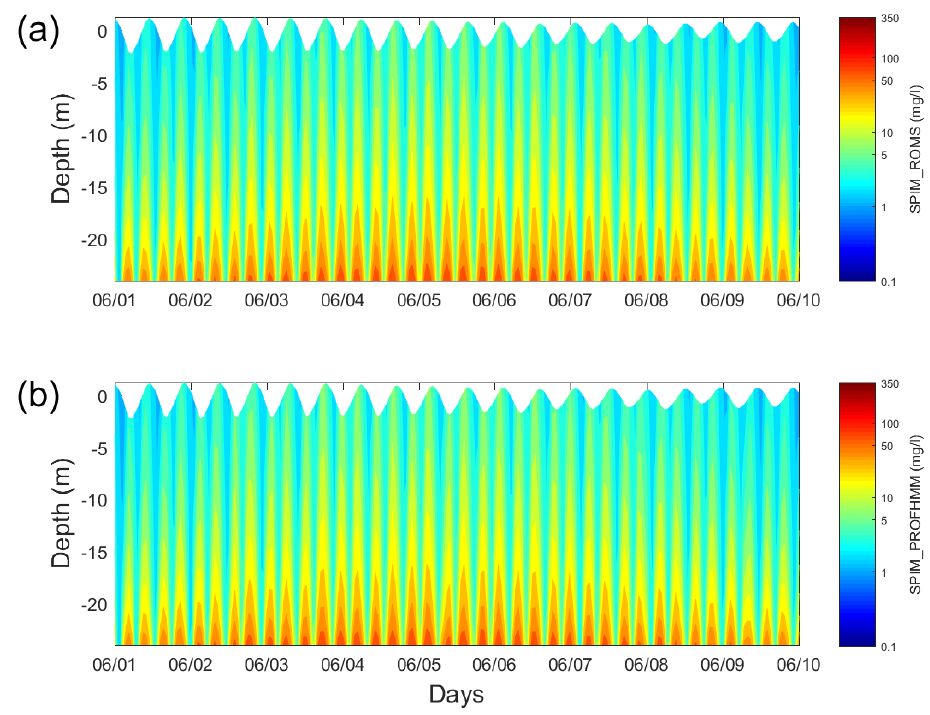
Figure 7. Learning phase of original suspended particulate inorganic matter (SPIM) section from Regional Ocean Modeling System (ROMS) data in ( a ), and corresponding PROFHMM-derived SPIM section in ( b ) from point M3 for 10-day spring tidal phase between 1 June 2008 and 10 June